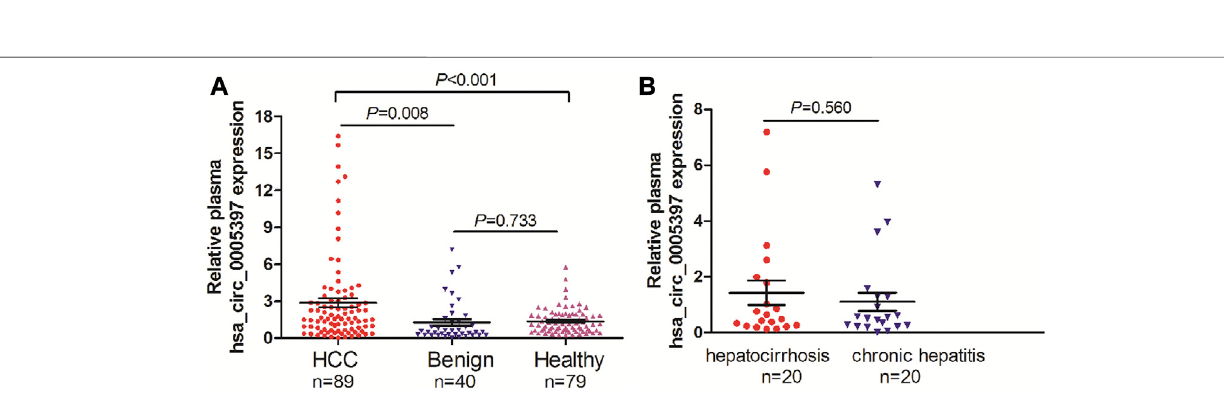
FIGURE 2 | Plasma hsa_circ_0005397 is increased in HCC patients. (A) Detection of plasma hsa_circ_0005397 expression levels in 89 patients with HCC, 40 patients with benign liver diseases and 79 healthy controls. (B) Detection of plasma hsa_circ_0005397 expression levels in 20 patients with chronic hepatitis and 20 patients with